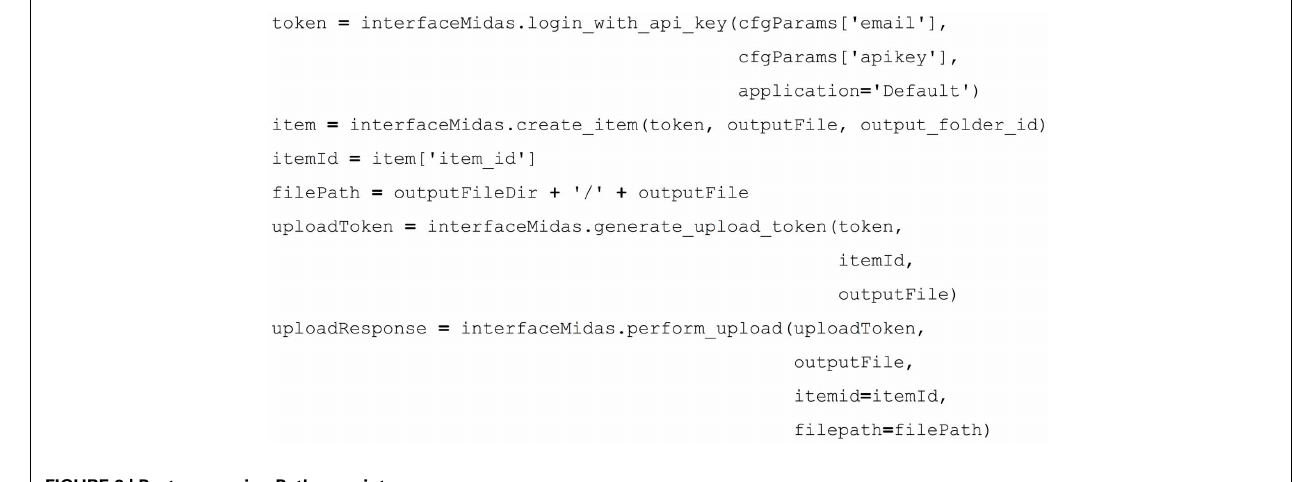
FIGURE 8 | Post-processing Python script.